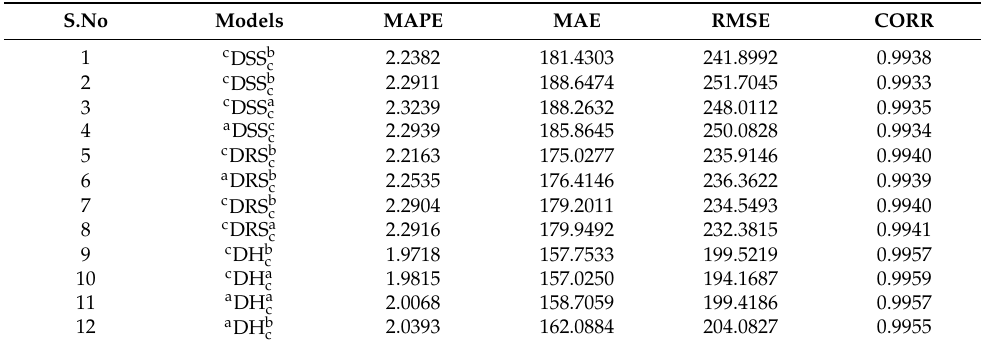
Table 5. Pakistan’s electricity consumption (kWh): mean forecast error of one-month-ahead post- sample for the best four models with DSS, DRS and DH decompositions.